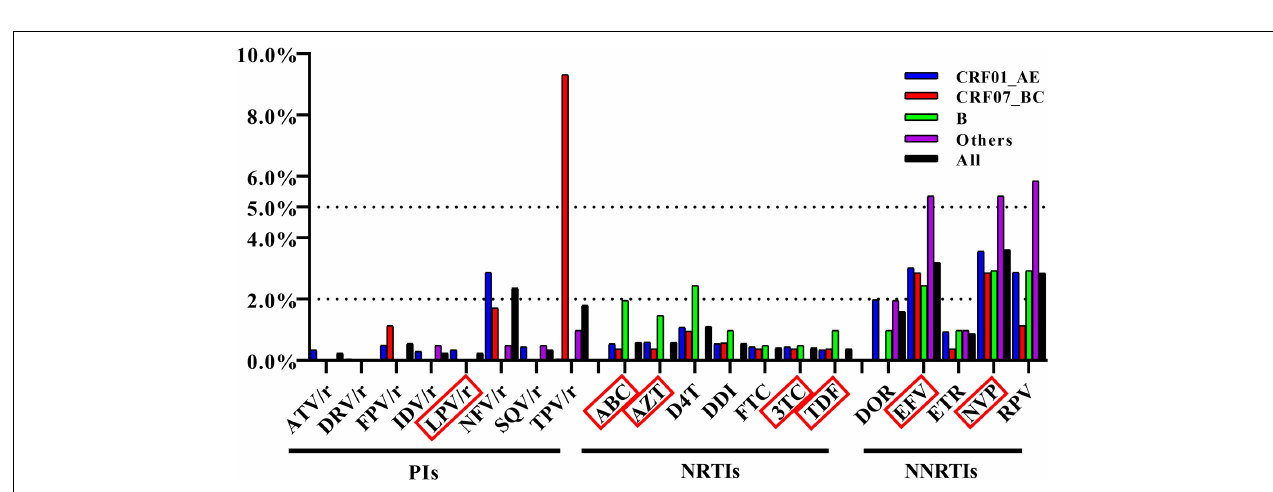
FIGURE 3 | Frequency of TDR across antiretroviral drugs. The antiretroviral drugs in red box were in the list of recommended antiretroviral drugs in China.